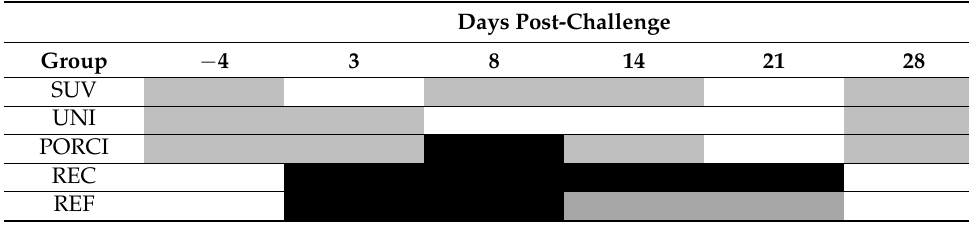
Table 2. Results of qRT-PCR test of oral fluid (OF) samples before ( − 4) and at day 3, 8, 14, 21 and 28 post-challenge. Negative samples are indicated as blank, one out of two positives in grey and two out of two OF positives in black.